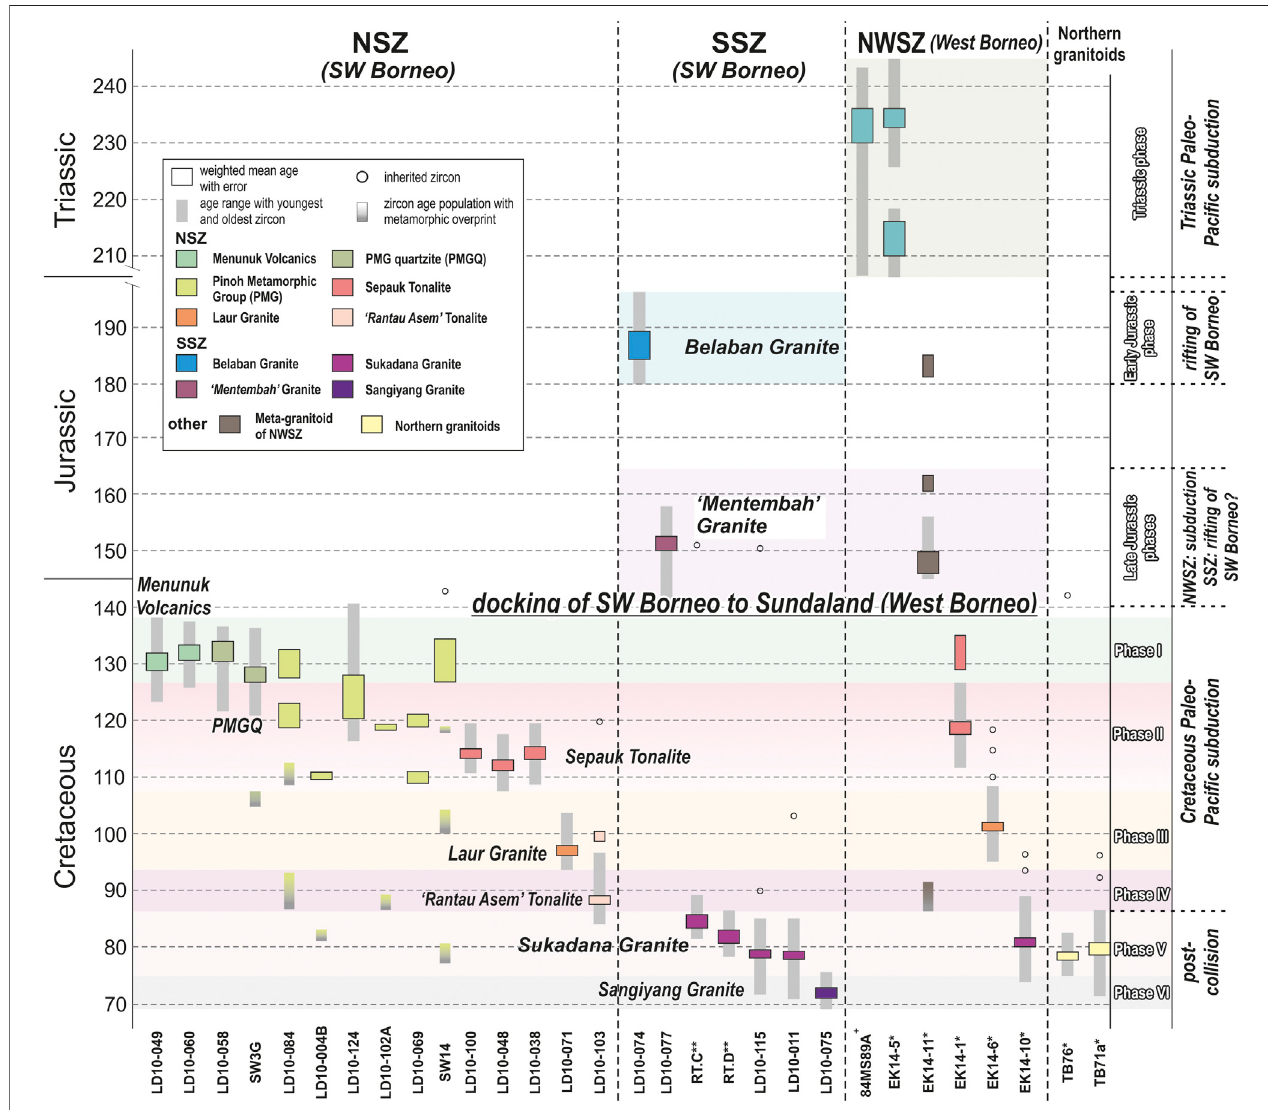
FIGURE 15 | Summary plot of Triassic to Cretaceous zircon U-Pb ages and subdivision of igneous phases in western Borneo. NSZ and SSZ from SW Borneo Block. NWSZ from West Borneo (part of Triassic Sundaland). Northern Granitoids from West Sarawak and central Kalimantan (Kuching Zone). (* age data from Hennig et al. (2017); ** age data from van Hattum et al. (2013); + age data from Setiawan et al. (2013)).